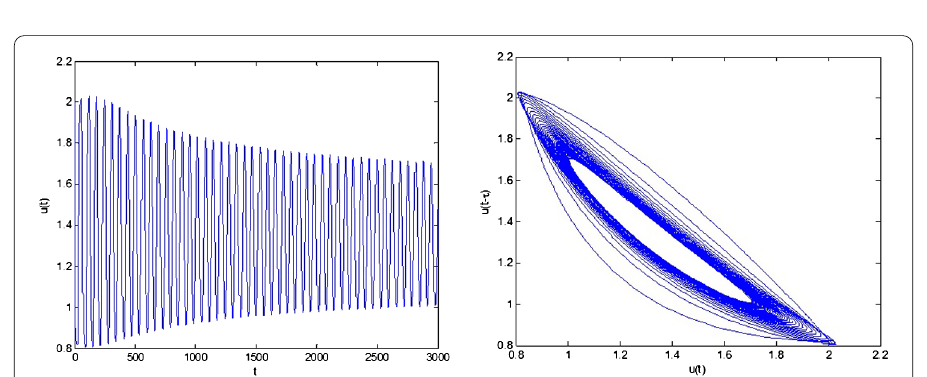
Figure 3 Waveform plot and phase portrait of the controlled fractional-order model (4.2) with α = 0.92, m = 0.2, k p = –0.05, k d = 0.5 and the initial value u 0 = 2. The equilibrium u ∗ is asymptotically stable when υ = 24 < υ c 0 = 27.7129.